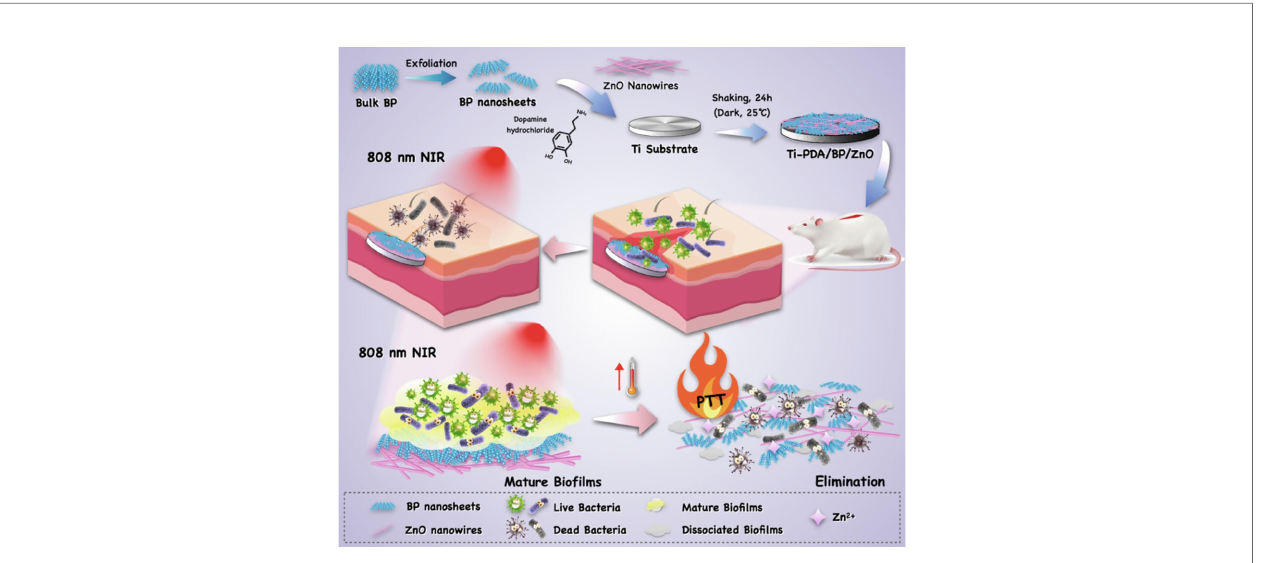
FIGURE 2 | Schematic illustration of Mn-ZIF-8 nanocomposite for antibacterial effects on infected wound model by eliminating bacteria (79). Copyright 2021,